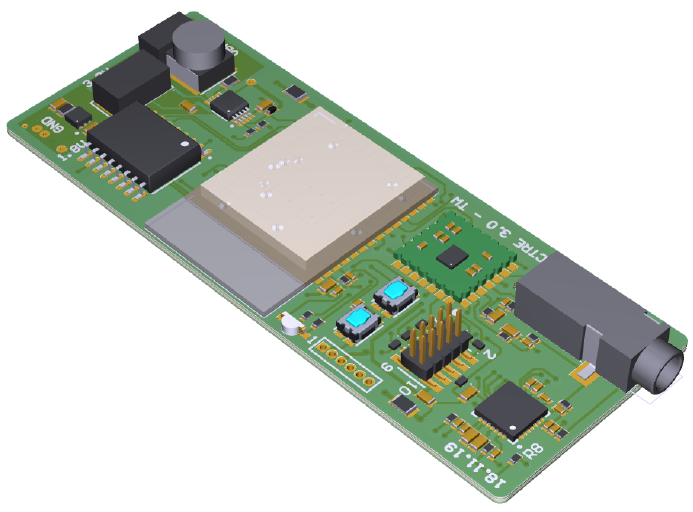
Figure 3. 3D model of the 28 × 73mm 2 measuring unit